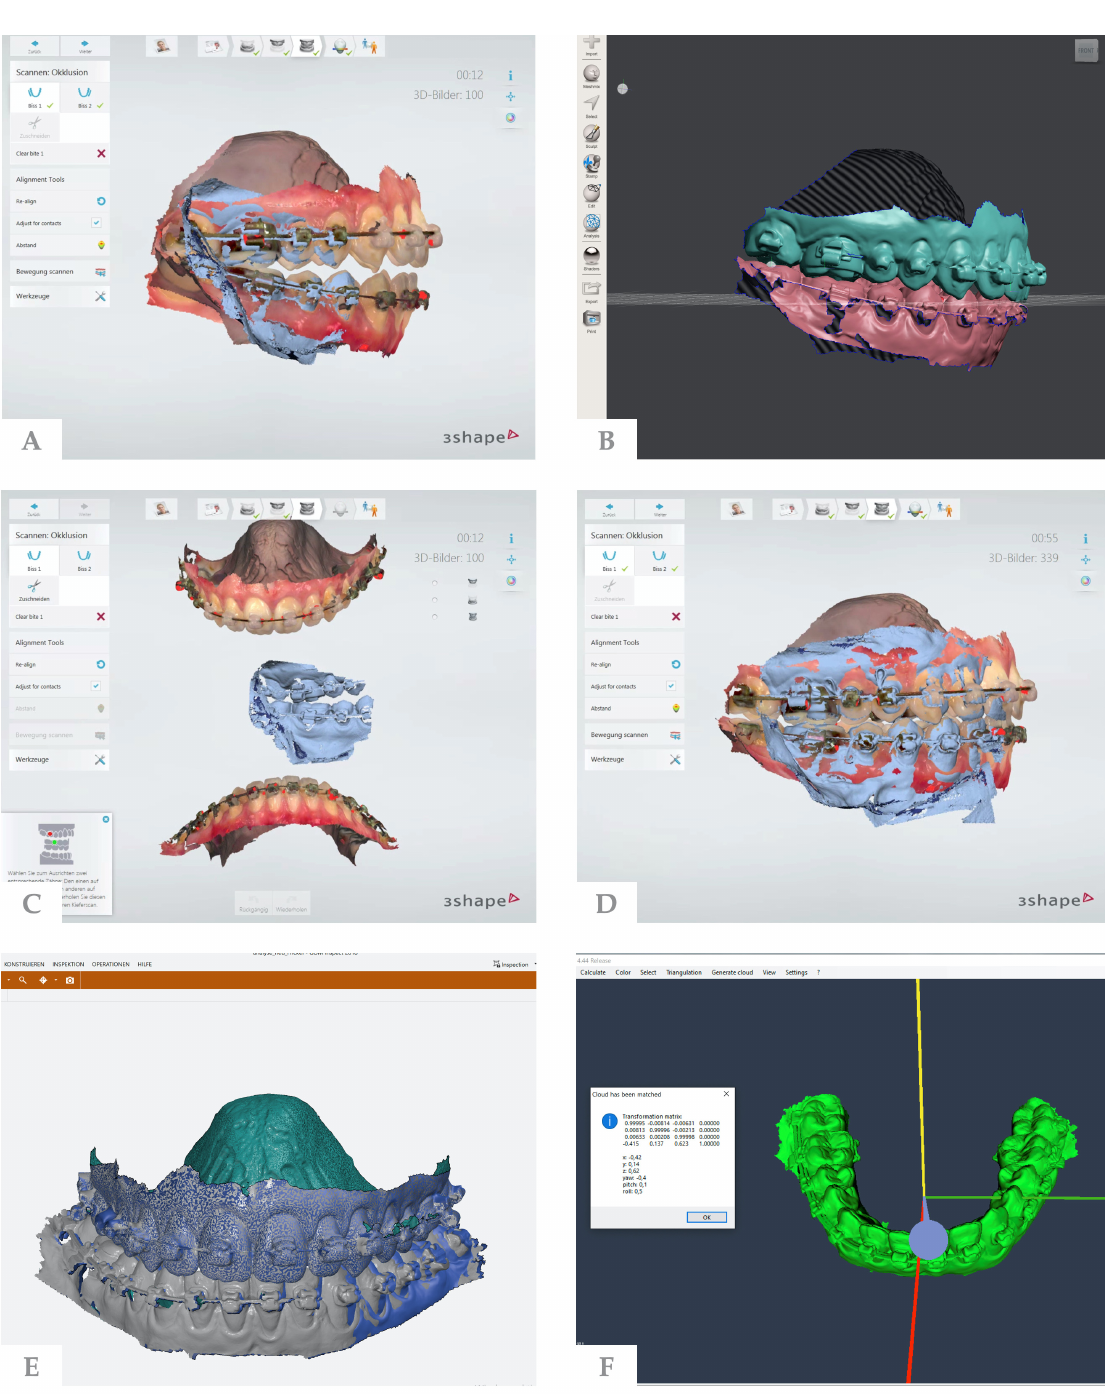
Figure 1. Evaluation process : ( A ) Preoperative upper and lower jaw scans aligned to each other via bite scans. ( B ) Final occlusion after virtual surgical planning of mandibular advancement. ( C ) On the day of the six-week follow-up examination. Based on the passive wires, it is assumed that no tooth movement has occurred between planning and follow-up. To obtain the postoperative occlusion the preoperative scans were duplicated, the bite scans were deleted and, thus, the relation of the upper to the lower jaw was removed. ( D ) New bite scans aligned the jaws in their postoperative position. ( E ) Planned occlusion (CAD element) and postoperative occlusion (actual data elements) were imported with GOM Inspect 2018. The maxilla served as a reference for registration. ( F ) Calculated translation matrix in pVision3D.